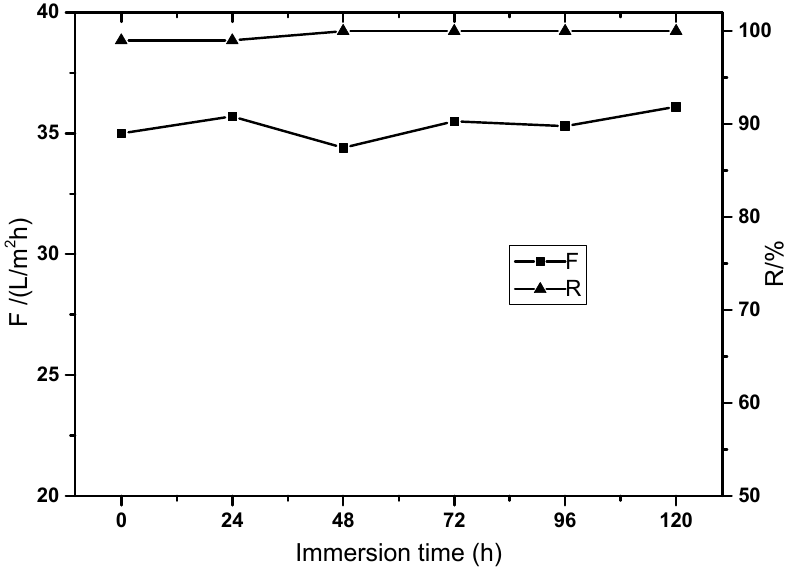
Figure 6. The solvent resistance in the P84/GO composite membrane.